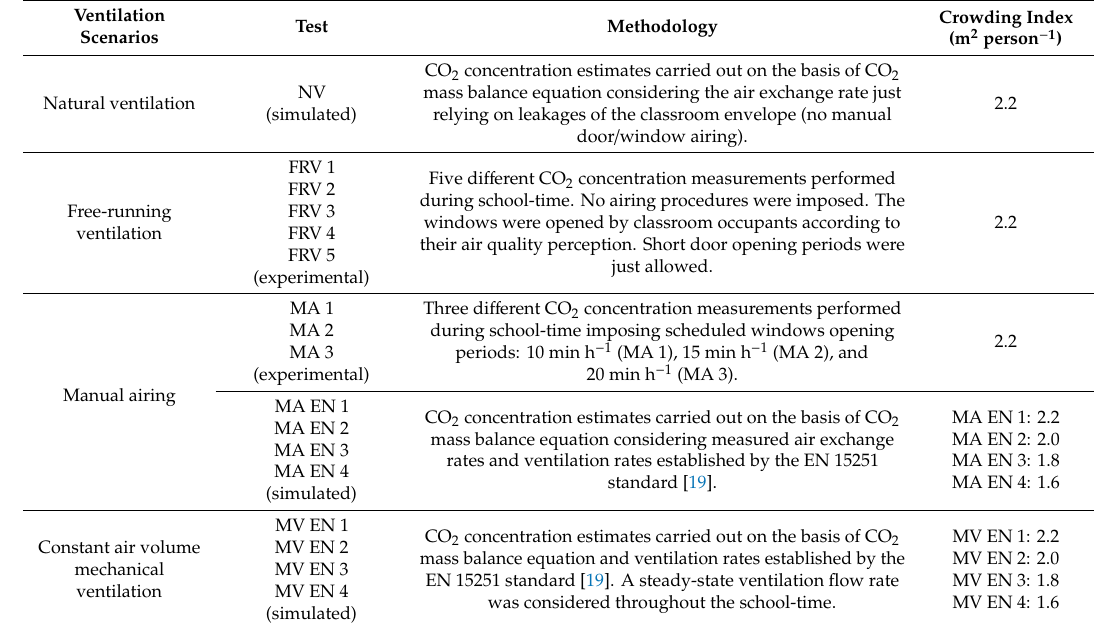
Table 2. Summary and details of the ventilation scenarios